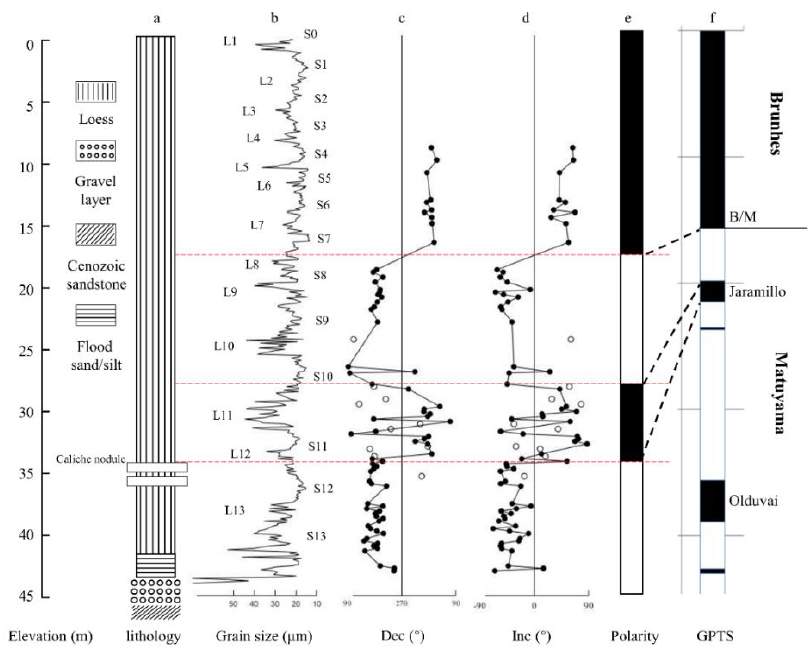
Figure 9. Lithology ( a ), median grain-size record ( b ), magnetostratigraphy ( c , d ) and the correlation of the polarity ( e ) between the sediment sequence covering the terrace (T8) at the NGC site (see field photo in Figure 5) and the GPTS ( f ): geomagnetic polarity time scale [67].